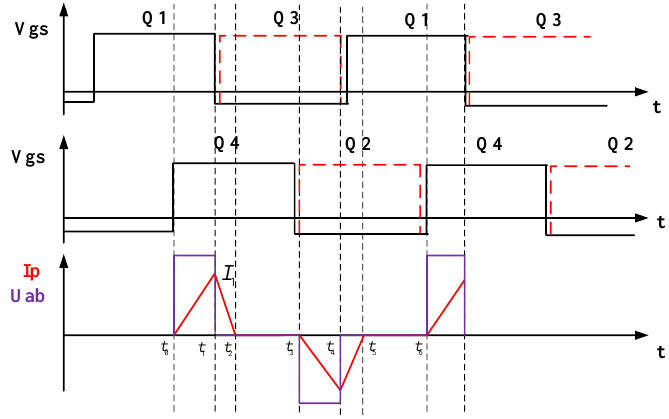
Figure 4. Schematic diagram of full-bridge inverter.